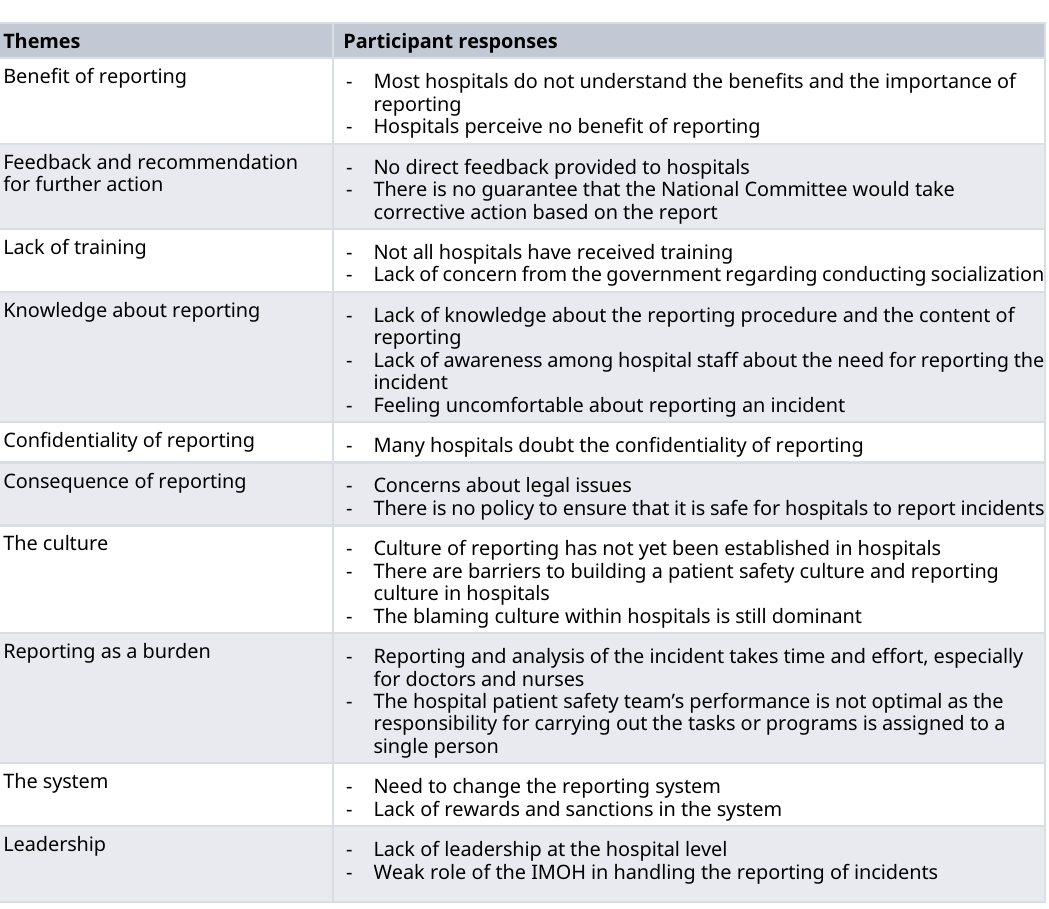
Table 2. Themes identified based on participant